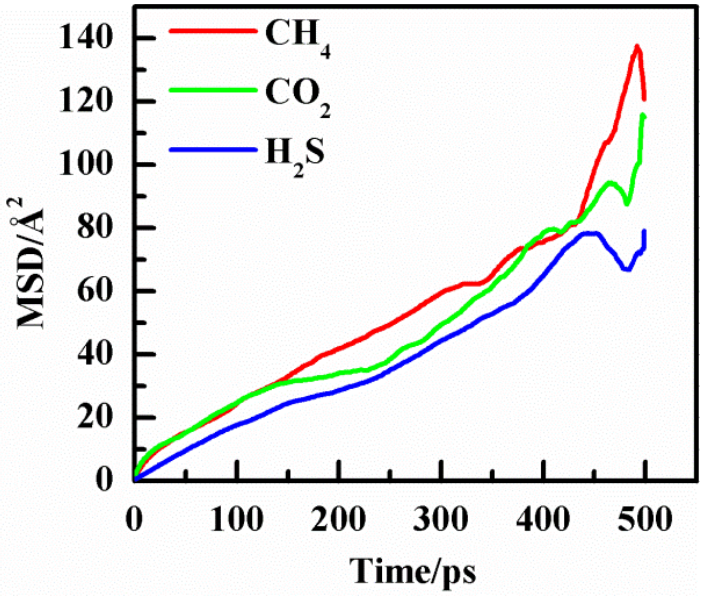
Polymers 2022 , 14 , x FOR PEER REVIEW Figure 7. Mean square displacement curve of gases in PVDF at2.5 MPa and 30 °C. Figure 7. Mean square displacement curve of gases in PVDF at 2.5 MPa and 30 ◦ C.